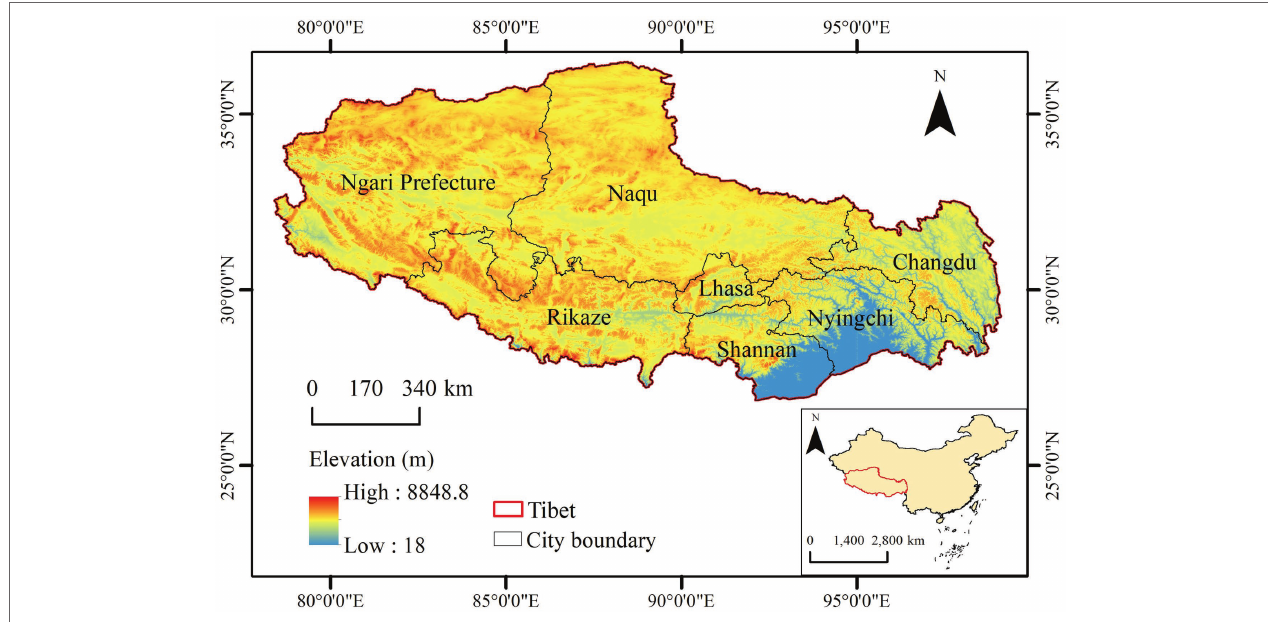
FIGURE 1 | Location and altitude distribution in the study